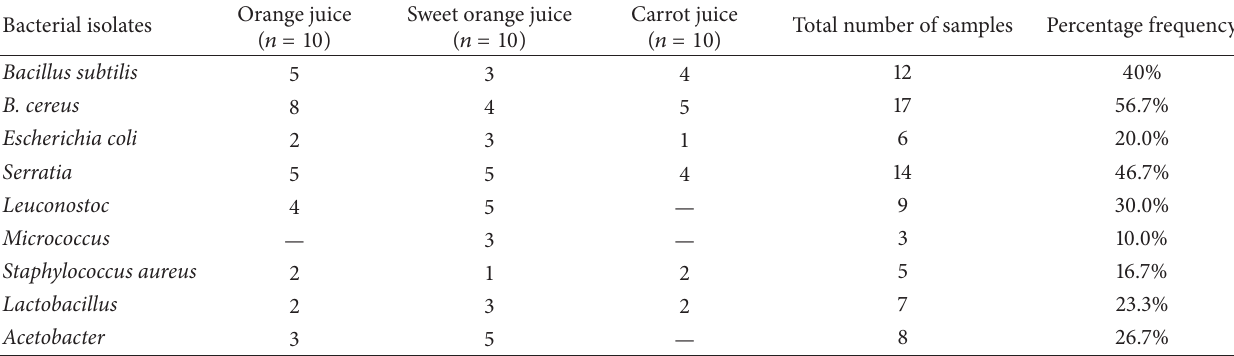
Table 8: Percentage abundance of bacterial isolates in juice samples.